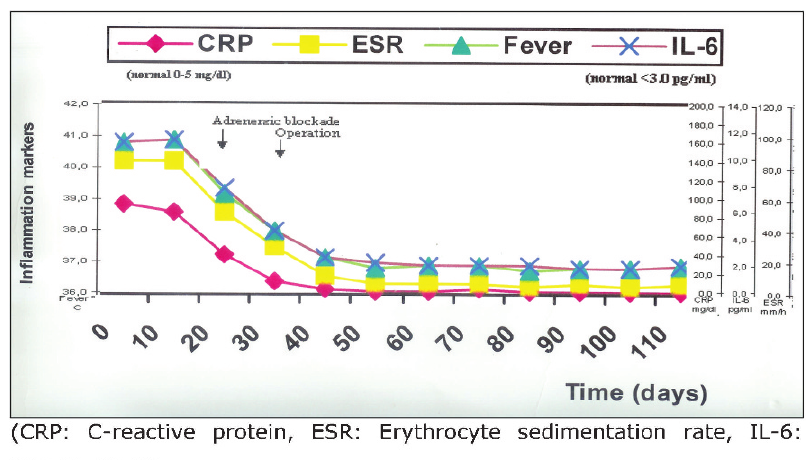
Figure 2 - Inflammation markers and IL-6 levels before and